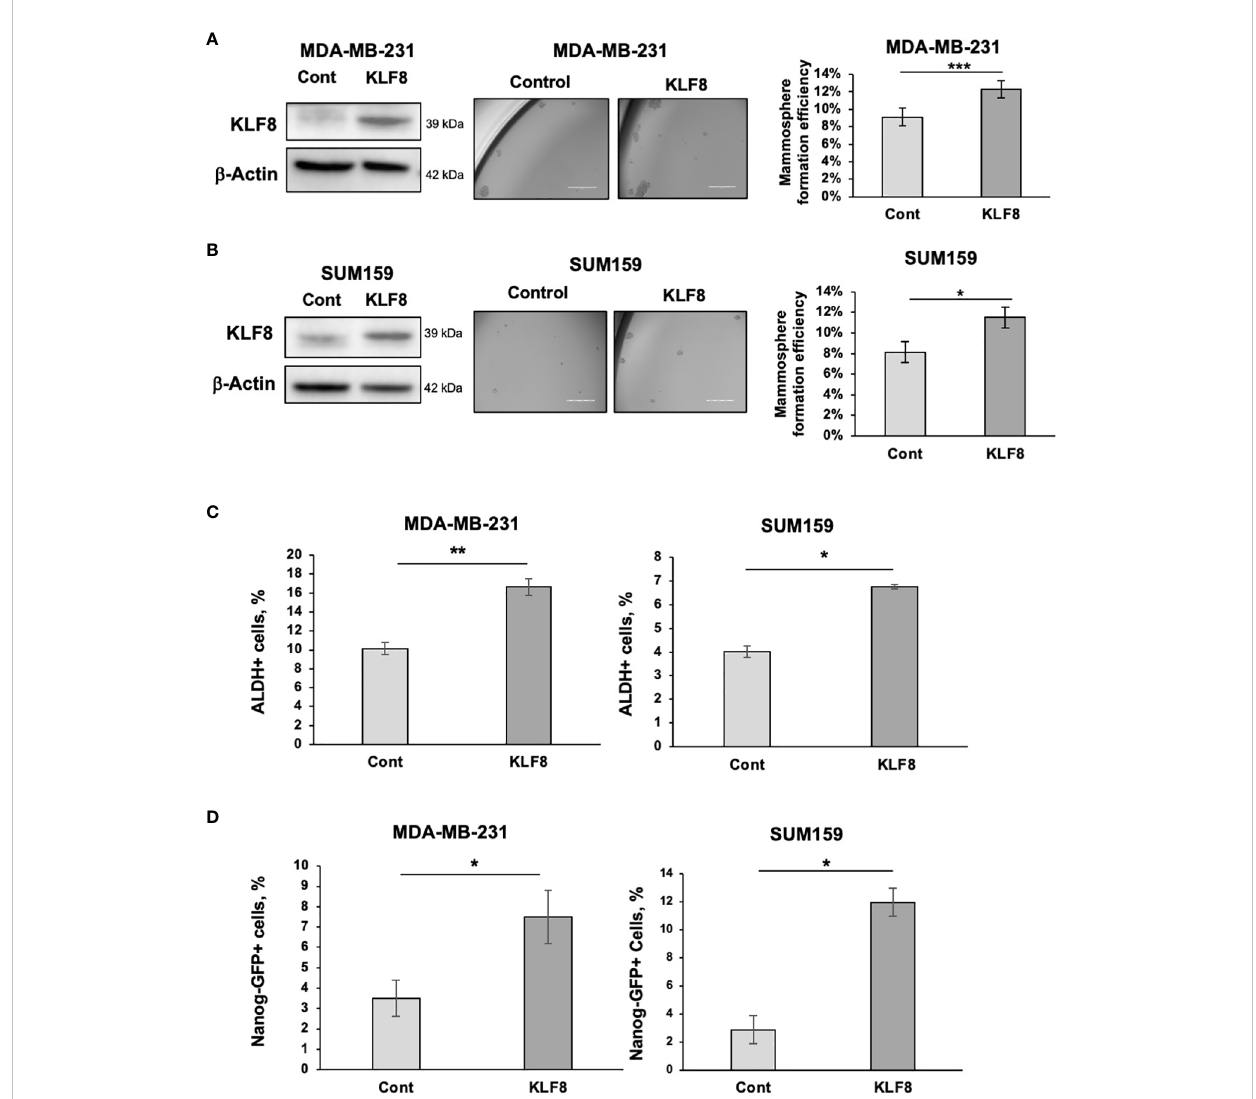
FIGURE 2 Elevated KLF8 expression increased mammosphere formation and CSCs population in TNBC cells. (A) Lysates from MDA-MB-231 cells stably overexpressing control or KLF8 were collected for immunoblot analysis using antibodies against indicated antibodies (left). MDA-MB-231 cells overexpressing control or KLF8 was grown in mammospheres formation assay for 5-7 days. Representative images of mammosphere were taken (middle) (scale bar 400 m m) and mammosphere larger than 50µm were counted and mammosphere formation ef fi ciency was quanti fi ed and graphed (right). (B) Lysates from SUM159 cells overexpressing control or KLF8 were collected for immunoblot analysis using indicated antibodies (left). SUM159 cells overexpressing control or KLF8 was grown in mammospheres formation assay for 5-7 days. Representative images of mammosphere were taken (middle) (scale bar 400 m m) and mammosphere larger than 50µm were counted and mammosphere formation ef fi ciency was quanti fi ed and graphed (right). (C) Quanti fi ed graph of ALDH+ CSCs population detected by fl ow cytometry from MDA-MB-231 and SUM159 cells overexpressing control or KLF8. (D) Quanti fi ed graph of NANOG-GFP+ CSCs population detected by fl ow cytometry from MDA-MB-231 and SUM159 cells overexpressing control or KLF8. Student t test reported as mean ± SEM, *p<0.05, **p<0.01, and